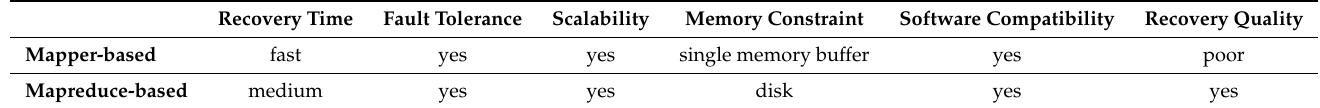
Table 2. Comparisons of our proposed